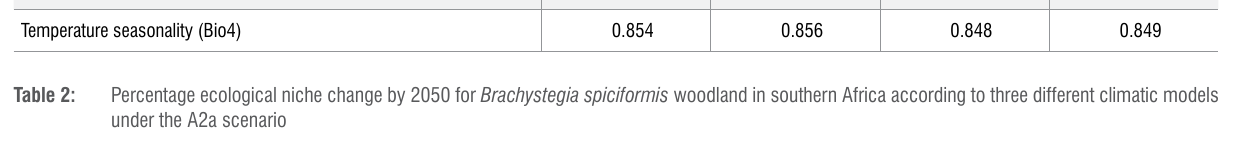
Ecological niche